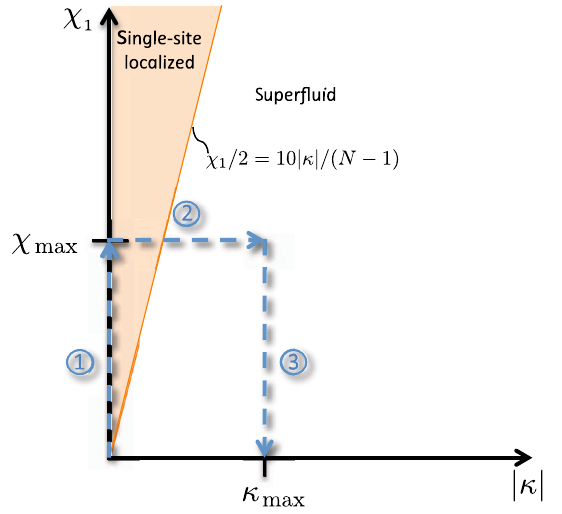
FIG. 5. Approximate phase diagram corresponding to the single-site nonlinearity model of Eq. (4). Dashed blue arrows indicate the first three steps of the entanglement